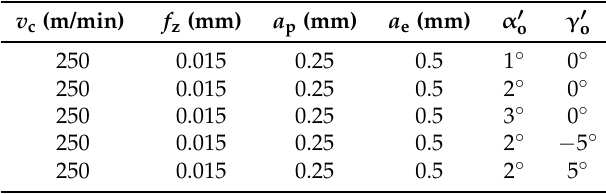
Table 2. Parameter combinations investigated in the experiments.